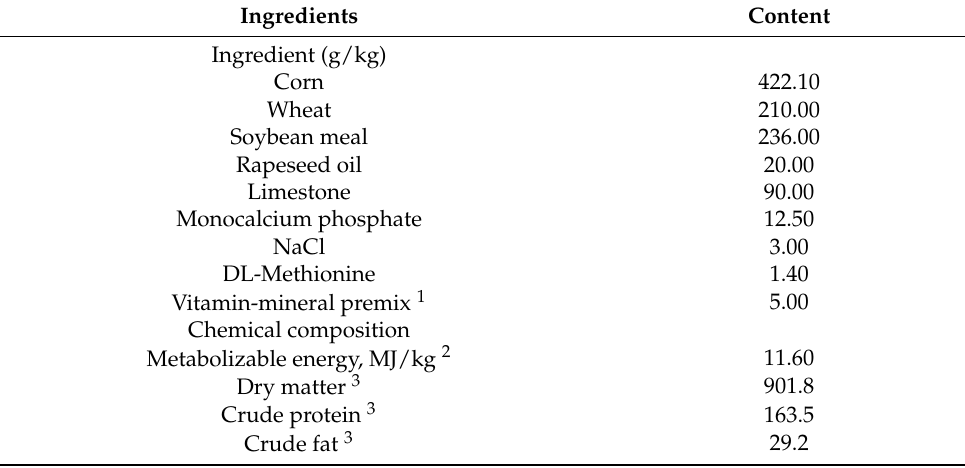
Table 1. Composition (g/kg) and nutritive value (g/kg) of the experimental diets (air-dry